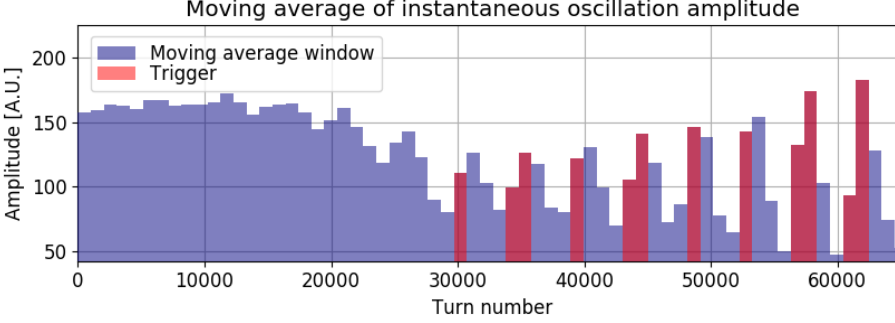
Figure 3. Moving average of instantaneous oscillation